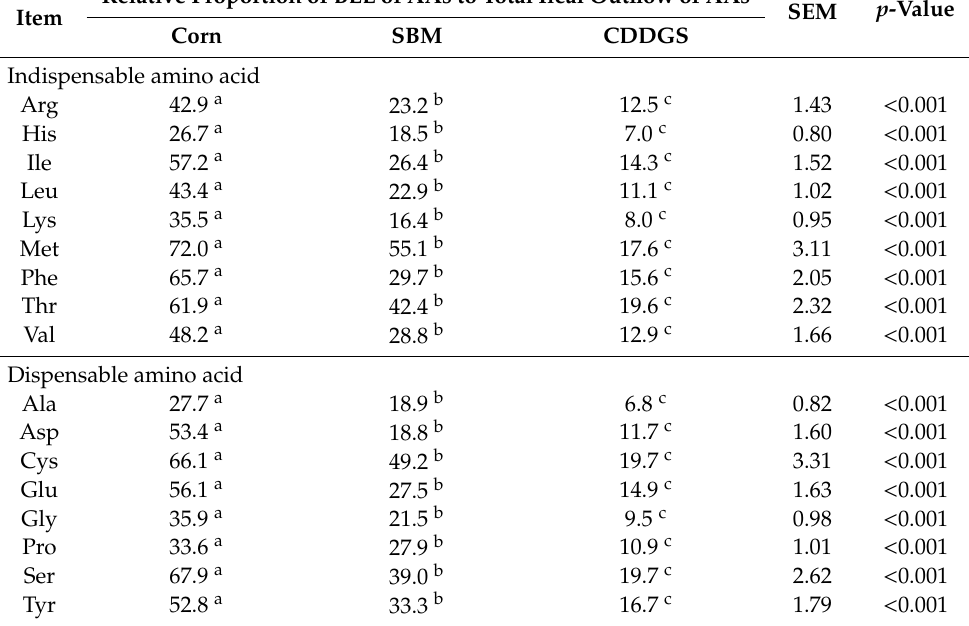
Table 7. Relative proportion of BEL of AAs to total ileal outflow of AAs (%) in broilers fed corn-, SBM-, or CDDGS -based diets.